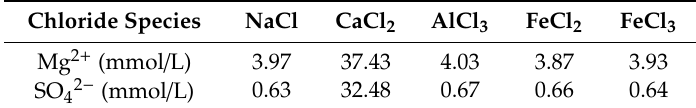
Table 2. Concentrations of Mg 2+ and SO 42 − in different chloride solutions used to immerse hardened paste for 28 days.